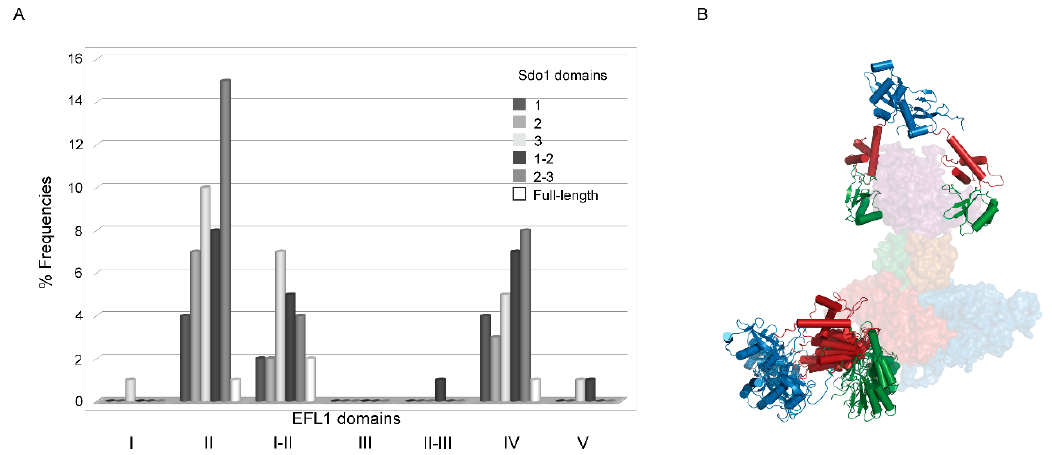
Figure 5 . Modelling of the yeast EFL1•Sdo1 complex based on the SAXS data. ( A ) Frequency of contacts between the different domains of the Sdo1 and EFL1 yeast proteins for the best 100 docking models. ( B ) Structure of the best 10 models, showing the interaction between the Sdo1 and EFL1 proteins and their relative positions in the complex. Sdo1 (ribbons) domain color code: blue—domain 1, red—domain 2, green—domain 3. EFL1 (surface) domain color code: blue—domain I, red—domain II, green—domain III, purple—domain IV, gold—domain V.